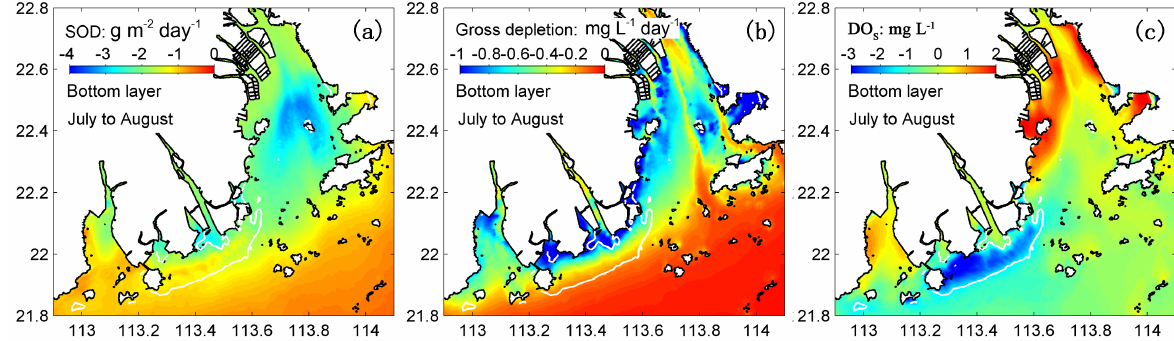
Figure 13. Spatial distributions of the monthly averaged (a) SOD, (b) gross depletion rates of DO, and (c) the concentrations of DO S at the bottom layer. Note that the HFZ is also shown here (denoted by the area encompassed by white